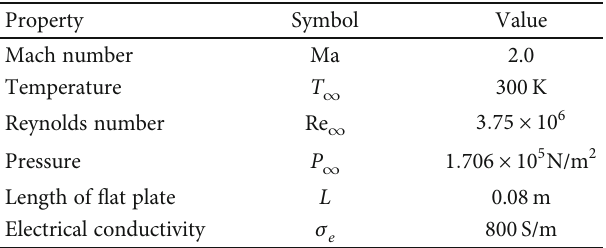
Figure 3: Comparison between pressure and heat transfer in 24 ° wedge-induced separated fl ows and experimental data provided by Holden. Table 2: Freestream conditions for fl at plate fl